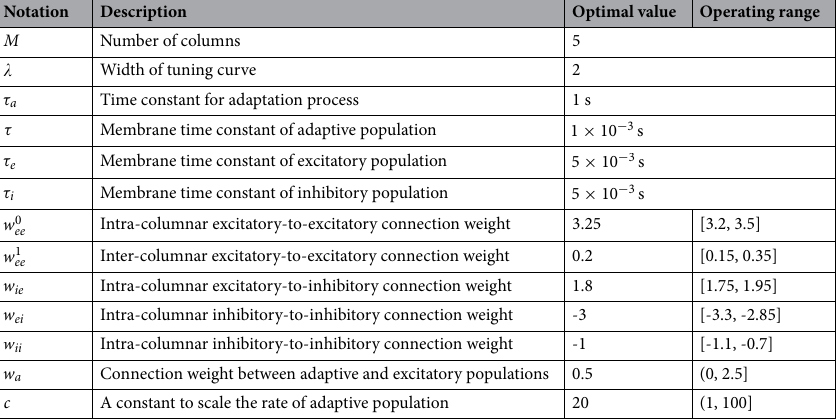
Table 2. Parameters in the mean-field model. Steps of 0.05, 0.1 and 1 are used to linearly search the operating ranges of the excitatory and inhibitory connection, adaptation connection weights and adaptation scaling factor, respectively. The parameter value is valid if the CSI metrics for SSA and TDD of the model based on that parameter value are positive. Values exceeding 100 for the adaptation scaling factor have not been tested since SSA and TDD vary very slightly when increasing the parameter linearly. The setup of simulated protocols is the same as that in Fig.